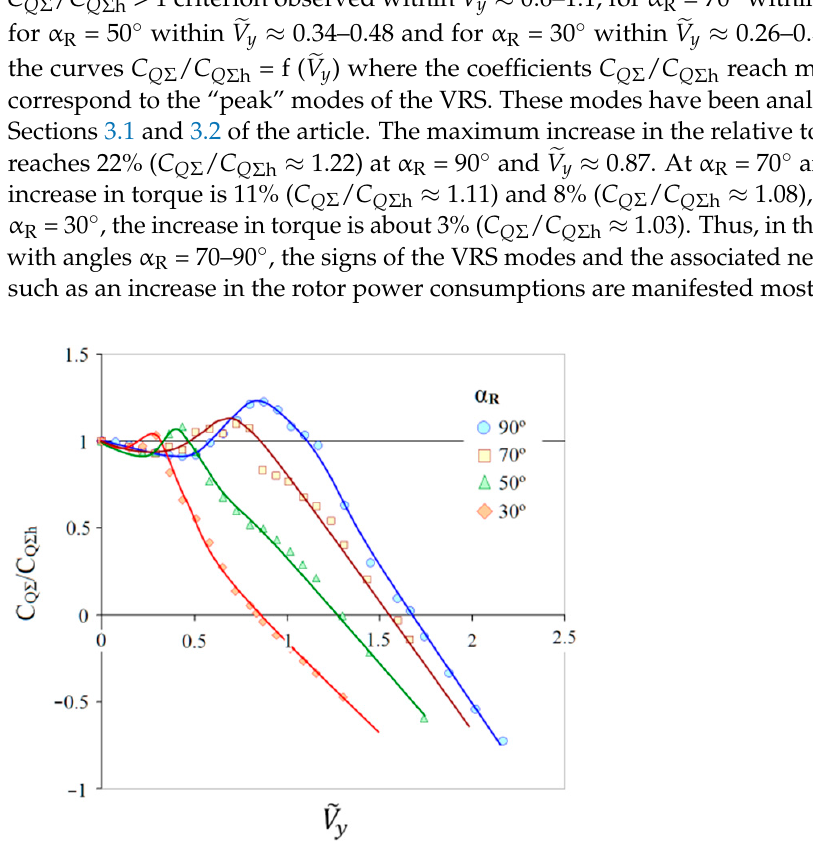
Figure 12. Dependencies of the relative torque coefficient C Q Σ / C Q Σ h vs. the non-dimensional vertical descent speed (cid:101) V y at α R = 30–90 ◦.